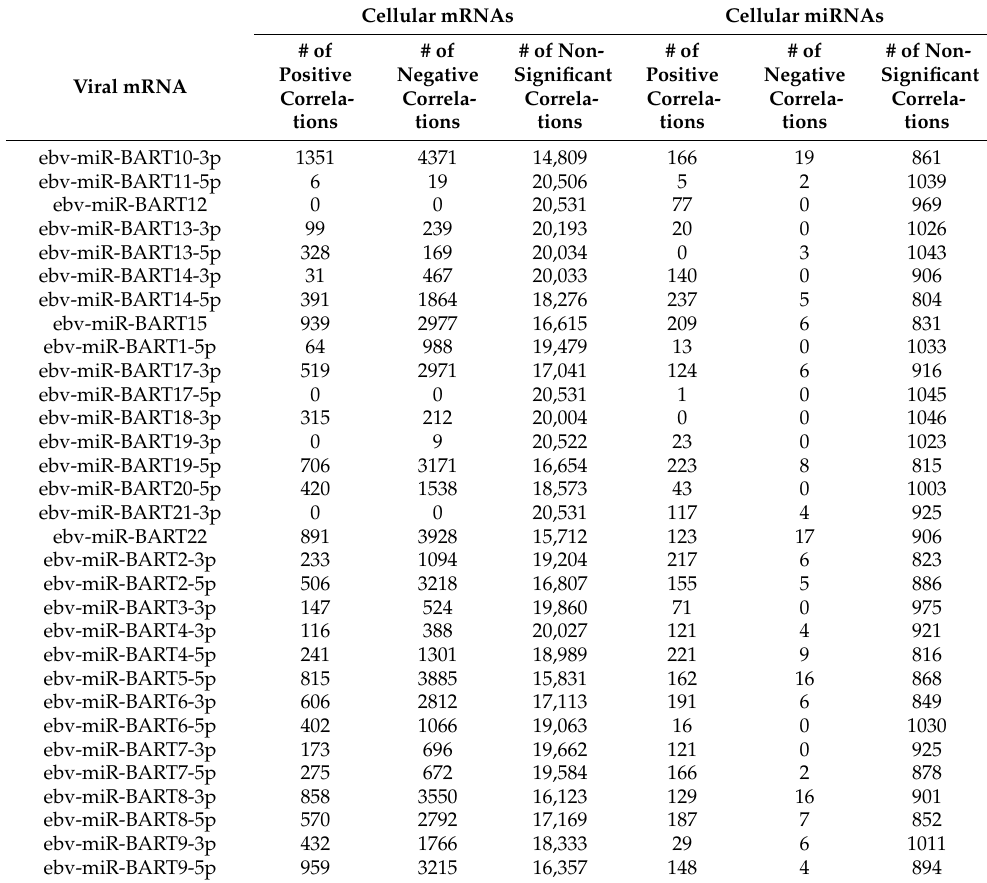
Table 4. Number of cellular mRNAs and miRNAs positively, negatively, or not significantly correlated with viral EBV miRNAs